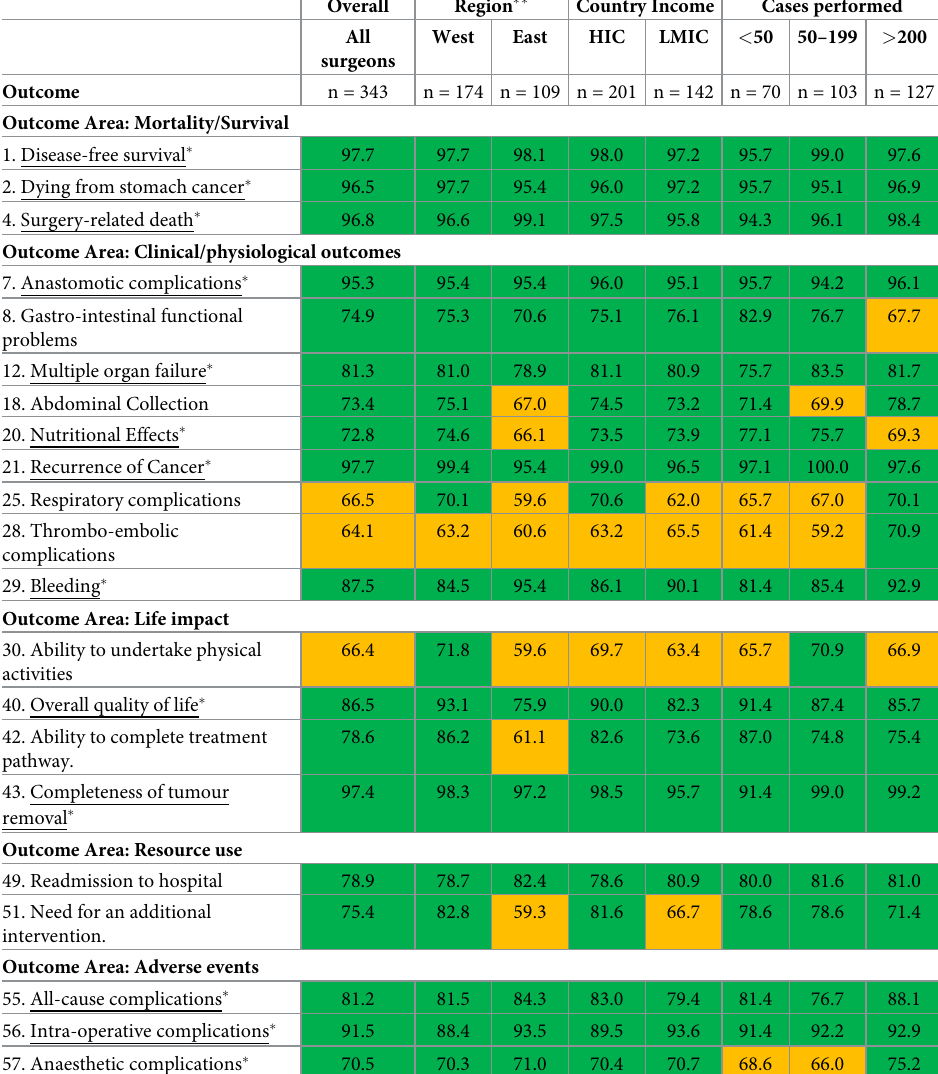
Values are the percentage of participants voting the outcome as critically important (score 7–9). Green = for inclusion, Yellow = no consensus. HIC = high income country, LMIC = low- to middle-income country; � Denotes outcomes are those which were included in the final list of outcomes for automatic inclusion in the COS. �� Participants not from either Western or Eastern countries were excluded from this